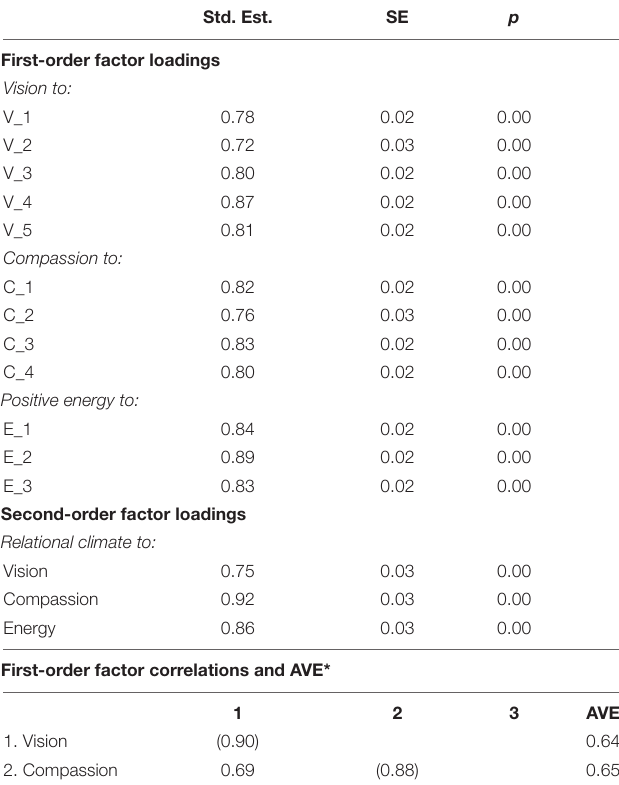
TABLE 10 | Measurement model factor loadings for Model 1A (Sample 2). Std.